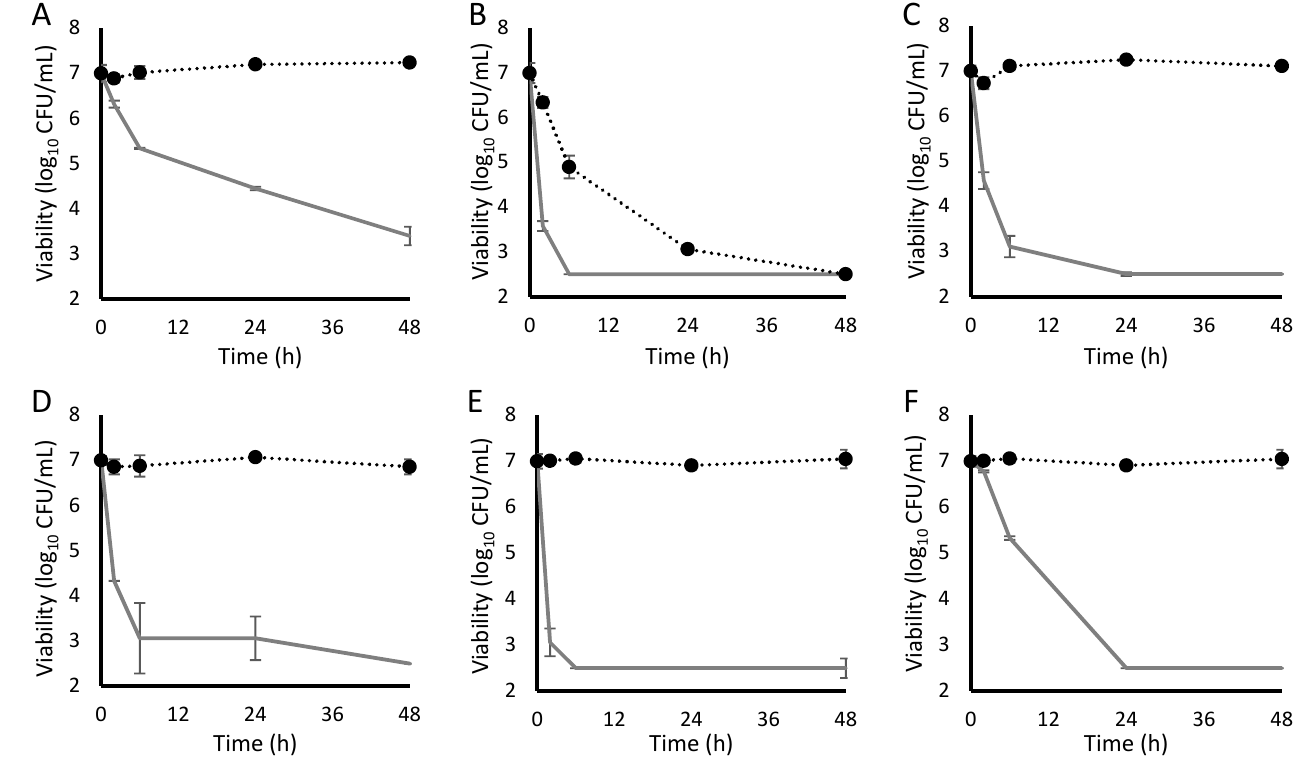
Figure 2. Activity of study antibiotics against induced-tolerant staphylococci determined in human serum. ( A ) ceftaroline; ( B ) daptomycin; ( C ) gentamicin; ( D ) levofloxacin; ( E ) oritavancin; and ( F ) vancomycin. Dotted line with black points, bacteria conditioned overnight in serum prior to antibiotic exposure; and gray line without points, bacteria inoculated into serum immediately prior to antibiotic exposure.